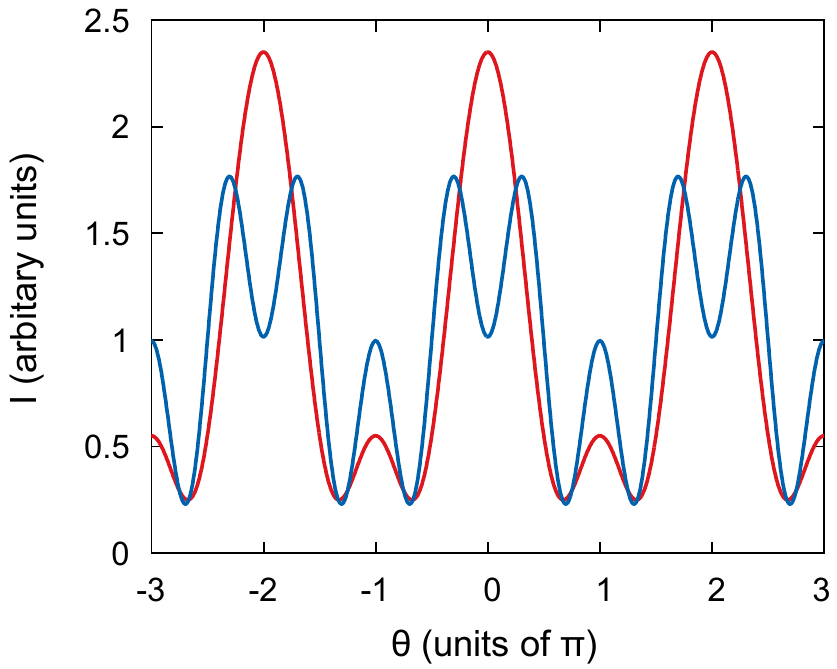
Figure 3: A four-path interference pattern, as it appears if the phase in one path has an additional π . The blue curve represents interference when no path-information is obtained. The red curve represents interference in the presence of a path detector, which can only tell if the quanton passes through path 4. Paradoxically, the intensity is clearly larger when the path information is